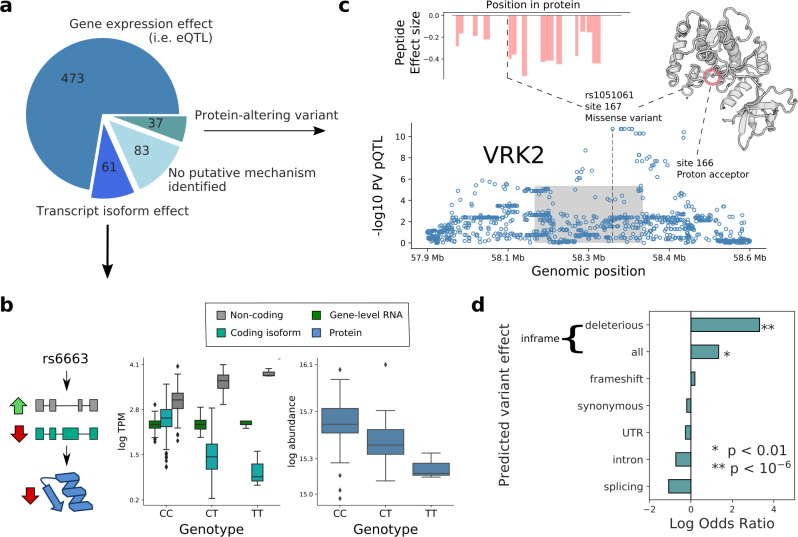
Putative mechanisms of pQTL from transcript isoform regulation and protein-altering variants.(a) Categorisation of 654 pQTL into four classes according to their putative mechanism: gene expression effect (i.e. replicated at eQTL level), transcript-isoform specific effect (i.e. not replicated at eQTL level, but significant at transcript isoform level), protein-altering variant (i.e. at least one inframe variant in LD with lead pQTL variant) without expression effect at RNA level, and without any putative mechanism identified. (b) Example pQTL without eQTL replication (rs6663; gene MMAB), with a directional opposite effect on a coding and non-coding isoform (cyan: ENST00000540016; grey: ENST00000537496), resulting in no overall change in gene expression level. (c) The pQTL variant (rs1051061) is a protein-altering variant associated with VRK2 protein abundance (below), and lacks detectable effect on RNA expression. The pQTL signal is observed across 15 peptides spanning the VRK2 protein sequence (above, left). This variant is associated with schizophrenia risk, and is located at the kinase active site, proximal to the proton acceptor residue (above, right). The dashed line and the grey box indicate the genomic positions of the lead QTL and of the gene. (d) Enrichment of RNA-independent pQTL in different categories of predicted variant effects, using gene variants in high LD with pQTLs (proxy gene variants; r2 >0.8; within the cis gene boundaries). Enrichment calculated using Fisher’s exact test.Figure 3—source data 1.tQTL_results.Consists of variants mapped at RNA, transcript isoform resolution, for genes detected at both RNA and protein levels. The table columns are analogous to Figure 2—source data 1 pQTL_results.Figure 3—source data 2.pepQTL results.Consists of variants mapped at the protein level, peptide resolution, for genes detected at both RNA and protein levels. The table columns are analogous to Figure 2—source data 1 pQTL_results.